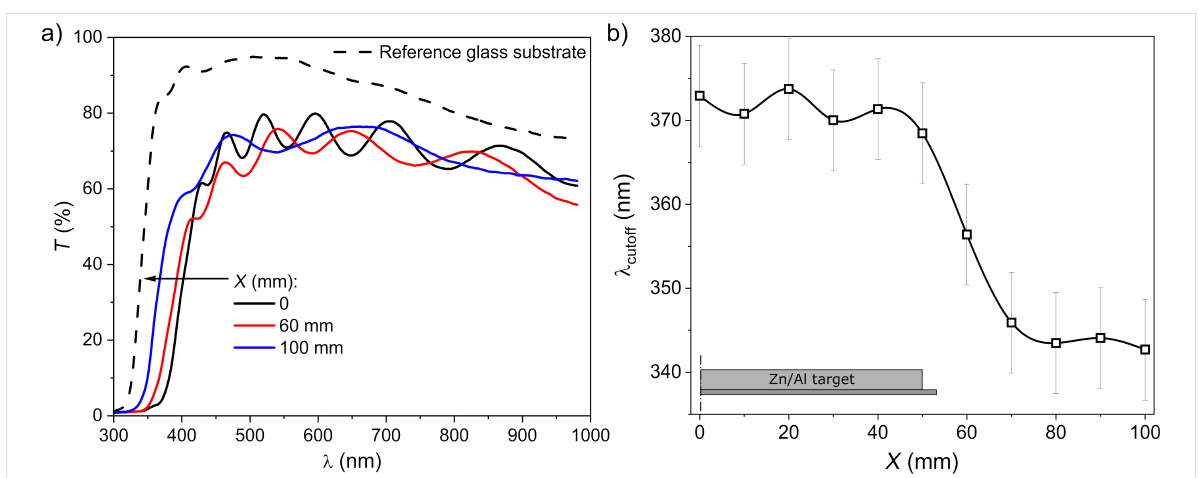
Figure 5: Results of investigations on optical transmission: (a) transmission ( T ) spectra and (b) dependence of the cut-off wavelength on the distance X from the Zn/Al target axis. The line in (b) is to guide the eye.